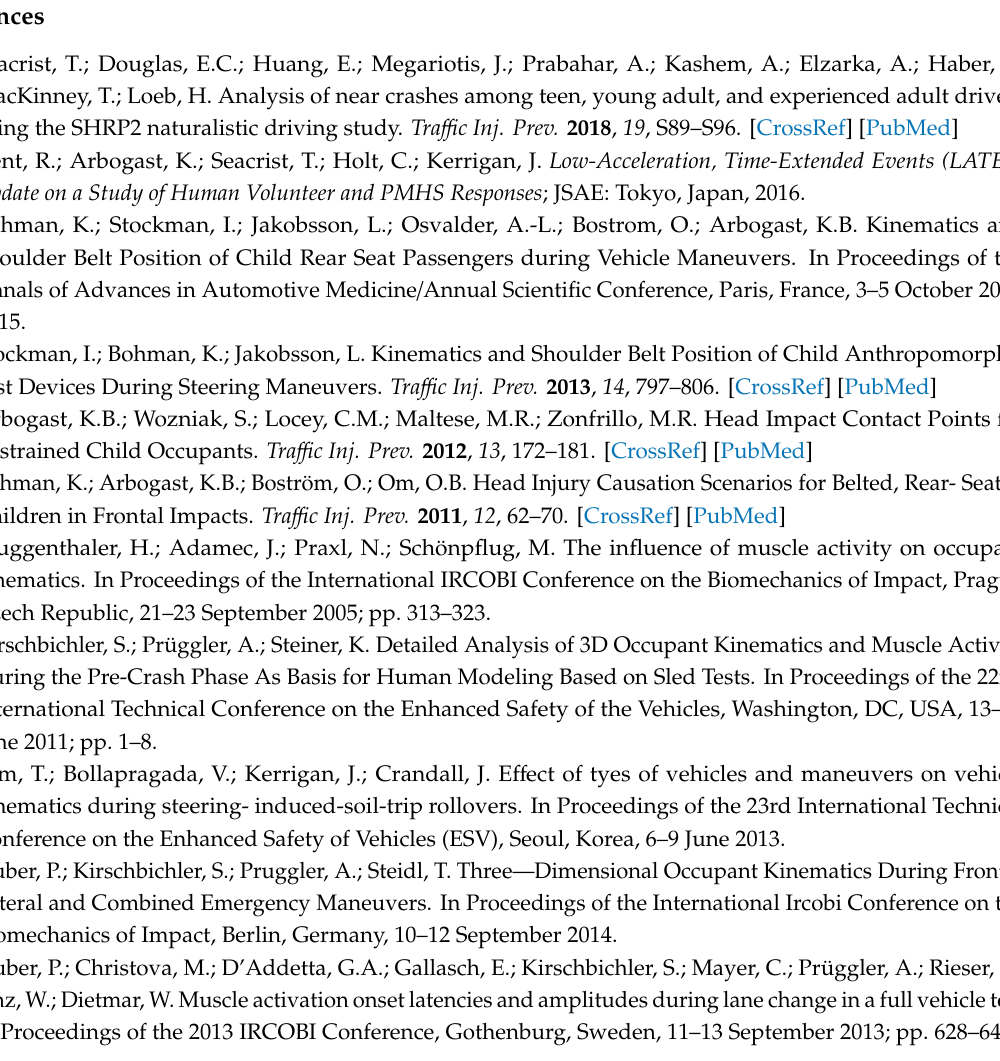
Figure 1 A. Time series of head and trunk displacement averaged for each age group. Figure A1. Time series of head and trunk displacement averaged for each age